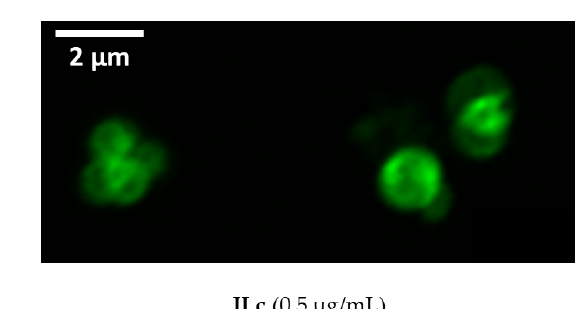
conjugate in presence or absence of antibacterial